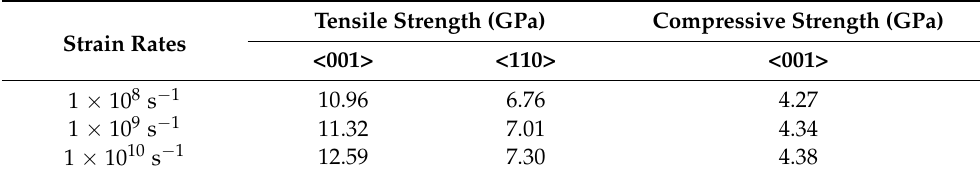
Figure 5. ( a ) Tensile stress-strain curves in direction <001> and <110> at different rates, ( b ) compres- sive stress-strain curves in direction <001> at different rates. Table 2. Tensile and compressive strength of CoCrNi at different strain rates.